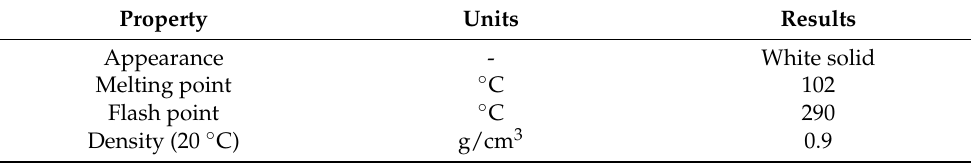
Table 2. Physical properties of